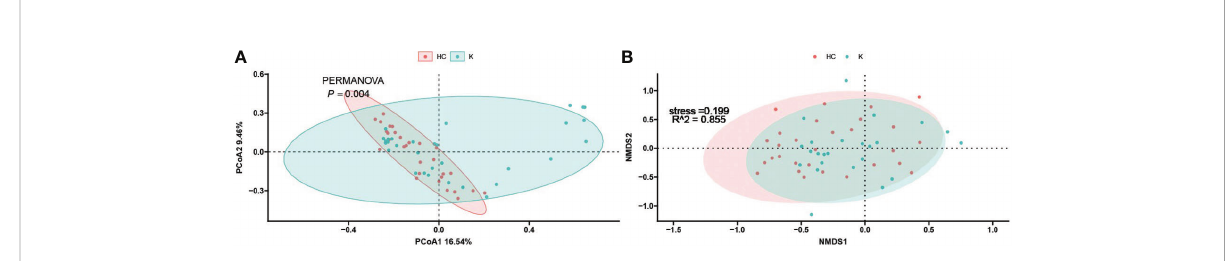
FIGURE 6 PCoA analysis (A) and NMDS results (B) for gut fl ora in the vasculitis